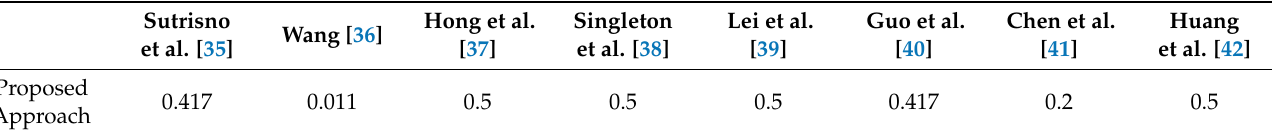
Table 11. The p -values from significant difference test of the proposed approach with the previous solution.